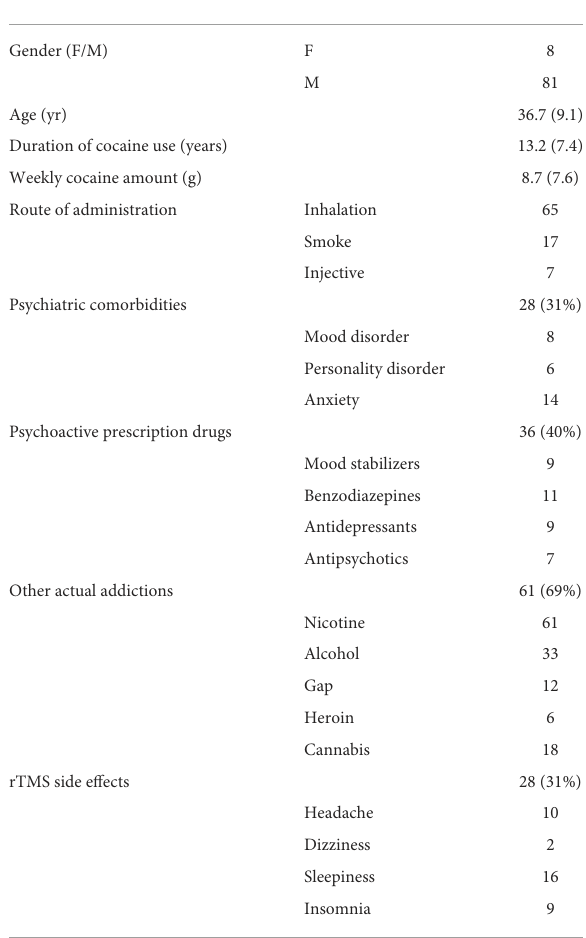
TABLE 1 Baseline socio- demographic and clinical characteristics of the sample. Data are expressed as mean and (standard deviation) or